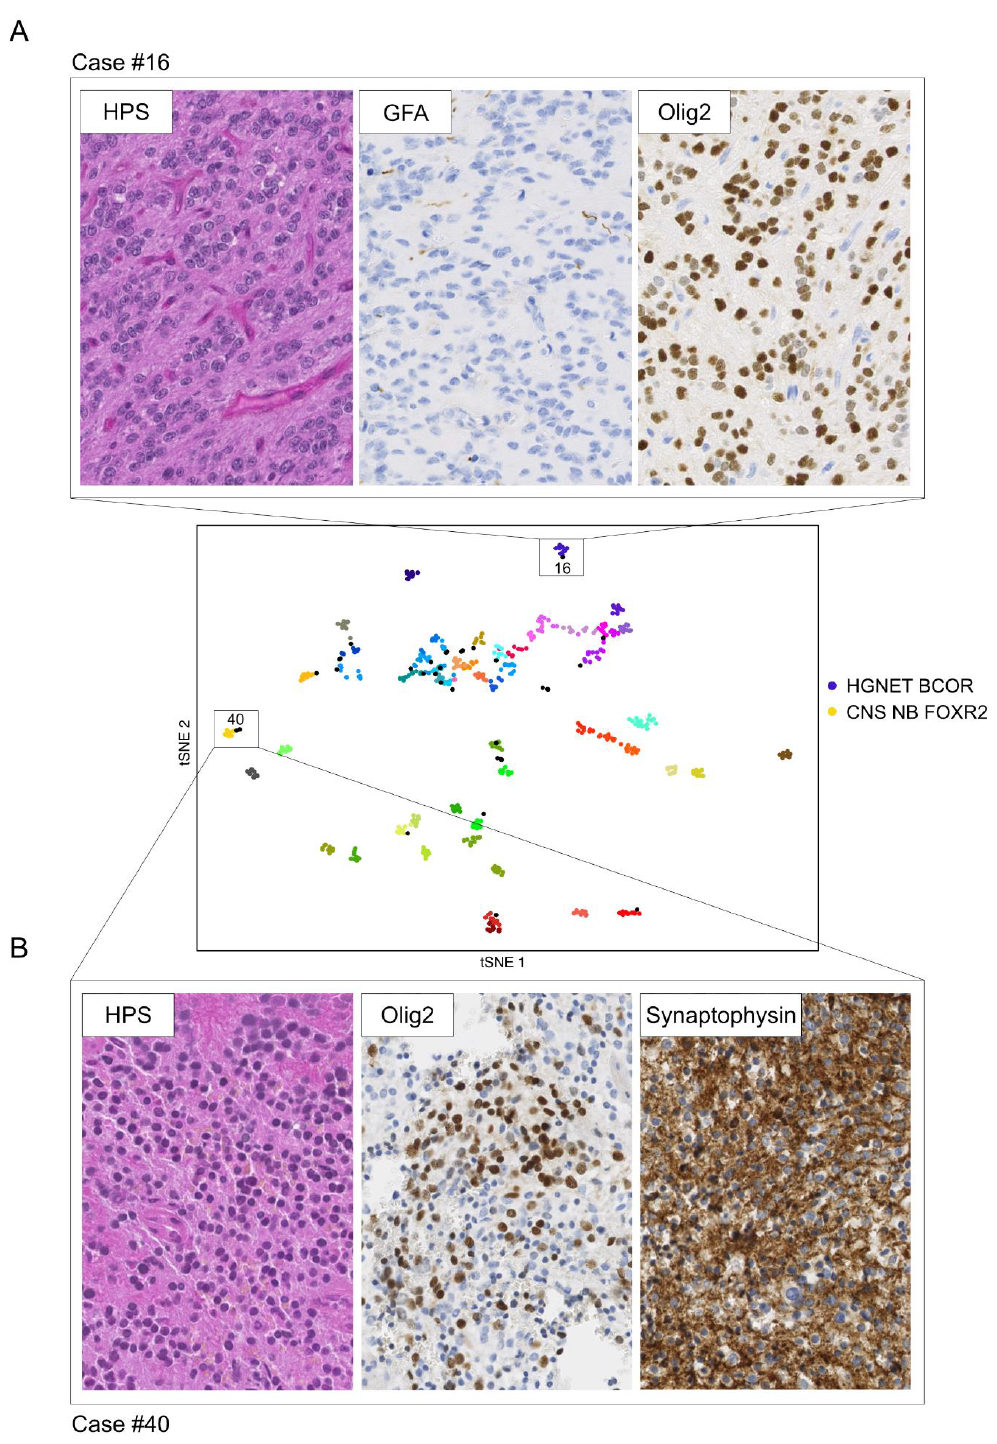
Figure 3. Examples illustrating the impact of the t-SNE analysis on establishing diagnosis. ( A ) Hematoxylin-phloxin-saffron stained sections of a compact ependymoma-like tumor with branching vessels showing no GFAP expression but Olig2 expression (case #16). The calibrated max-score was 0.57 for HGNET BCOR. The sample clustered with the tumors of the HGNET-BCOR methylation class reinforcing the underlying assumption subsequently confirmed by RNA sequencing detecting an EP300:BCOR fusion (case previously reported in [14]). ( B ) Hematoxylin-phloxin-saffron stained sections of a tumor composed of uniform round embryonal cells showing Olig2 and synaptopysin expression consistent with the diagnosis of CNS NB-FOXR2 (case #40). Calibrated max-score was non-informative (0.31 for DMG H3K27 mutant). The sample clearly clustered with the tumors of the CNS NB-FOXR2 methylation class. Magnification